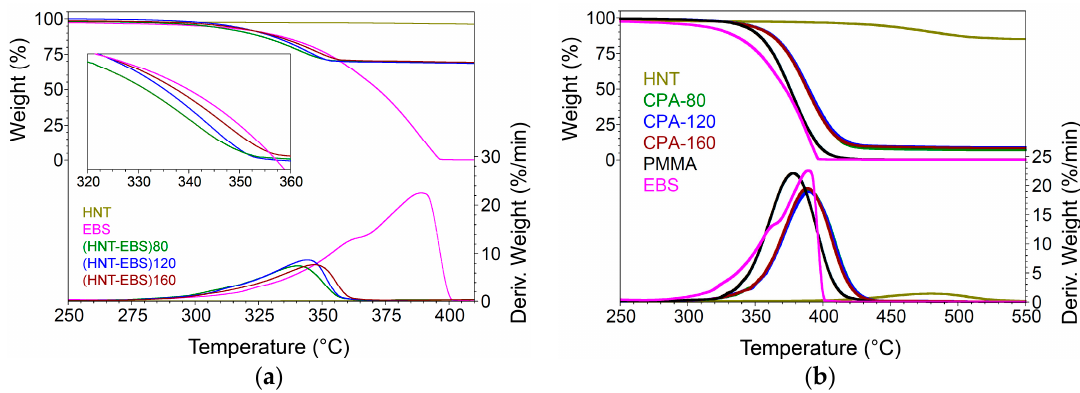
Figure 1. TGA results ( a ) catalytic effect of halloysite nanotubes (HNT) for N , N ′ -ethylenebis(stearamide) (EBS) thermal decomposition in HNT-EBS decorated hybrids ( b ) synergistic effects between EBS and PMMA decomposition fractions able to improve masterbatches maximal decomposition temperature.